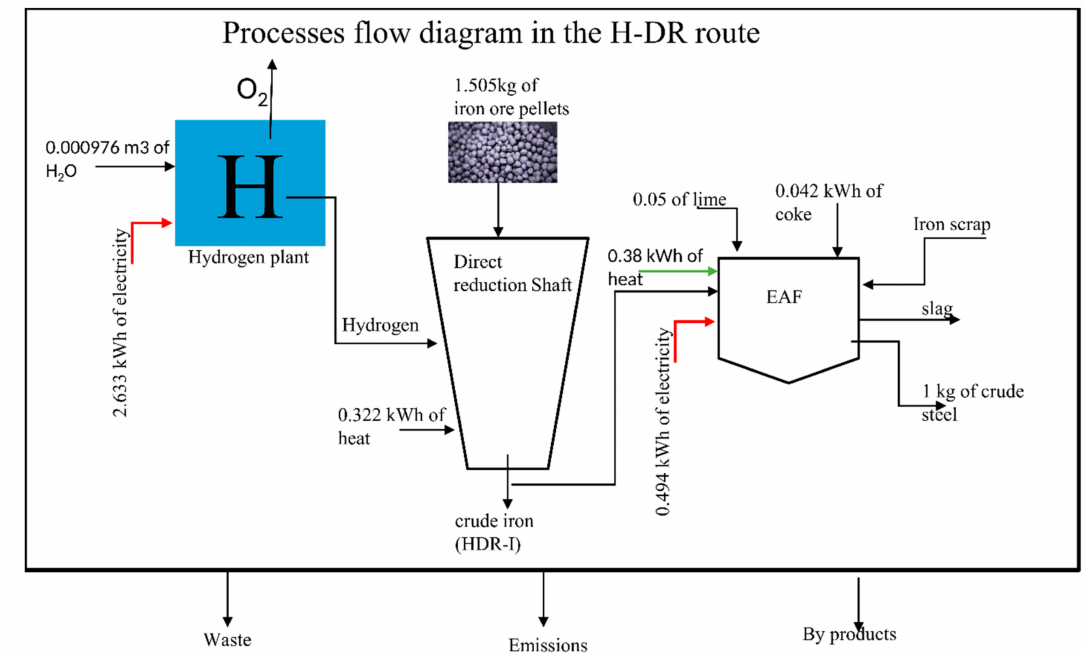
Figure 3. Inventory and process flow diagram for hydrogen direct reduction (H-DR) route for iron and steel production in HighRES